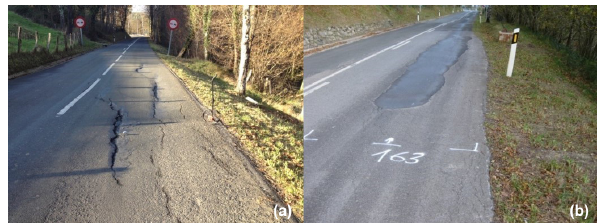
Figure 9. Road sections situated within slow-moving landslides with damage shown: (a) PoR C3C of the road GI-2133 (from km 8.280) with observed deformations and cracks on the road pave- ment; (b) PoR C9G of the road GI-2637 (from km 17.891 to 18.220) showing minor cracks already